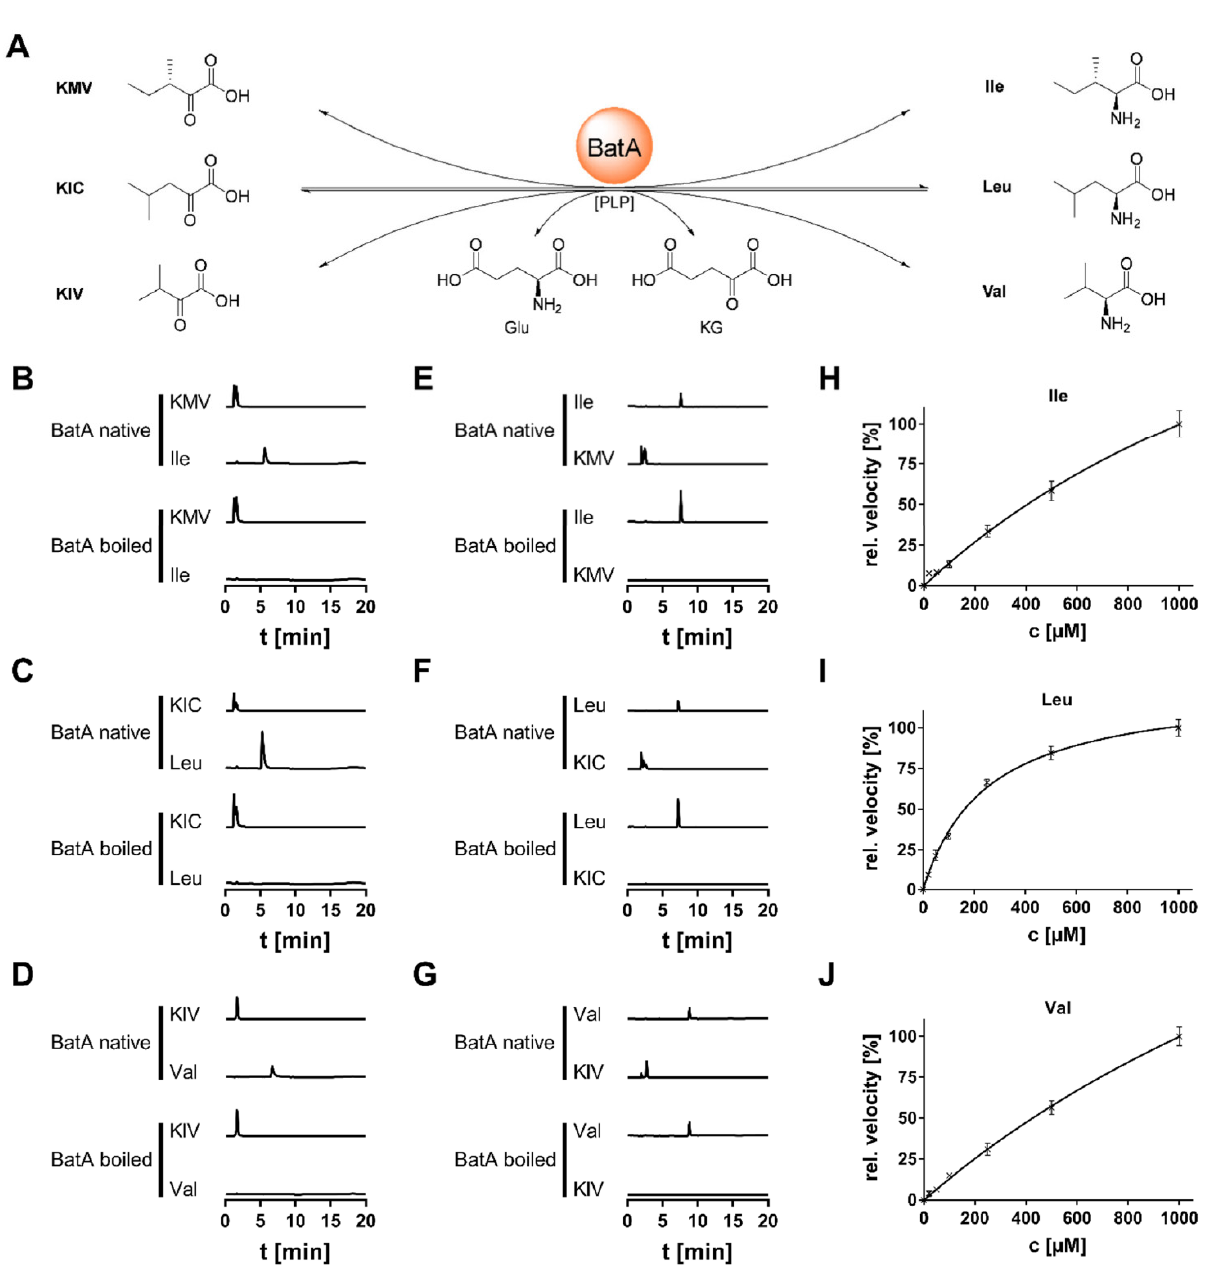
Figure 5. Conversion of α -keto acids and BCAAs by BatA from M. alpina . ( A ) Schematic representation of the BatA-catalysed reaction. ( B – G ) Extracted ion chromatograms of BatA reaction mixtures using α -keto acids ( B – D ) or their corresponding BCAAs ( E – G ) as substrates. The reaction was carried out with both the native and heat-inactivated enzyme. Commercial standards served as references. Note that branched-chain keto acids undergo stabilized keto-enol tautomerisation under physiologic conditions, resulting in a twin peak. ( H – J ) Michaelis–Menten kinetics for Ile ( H ), Leu ( I ), and Val ( J ). For kinetic parameters refer to Table